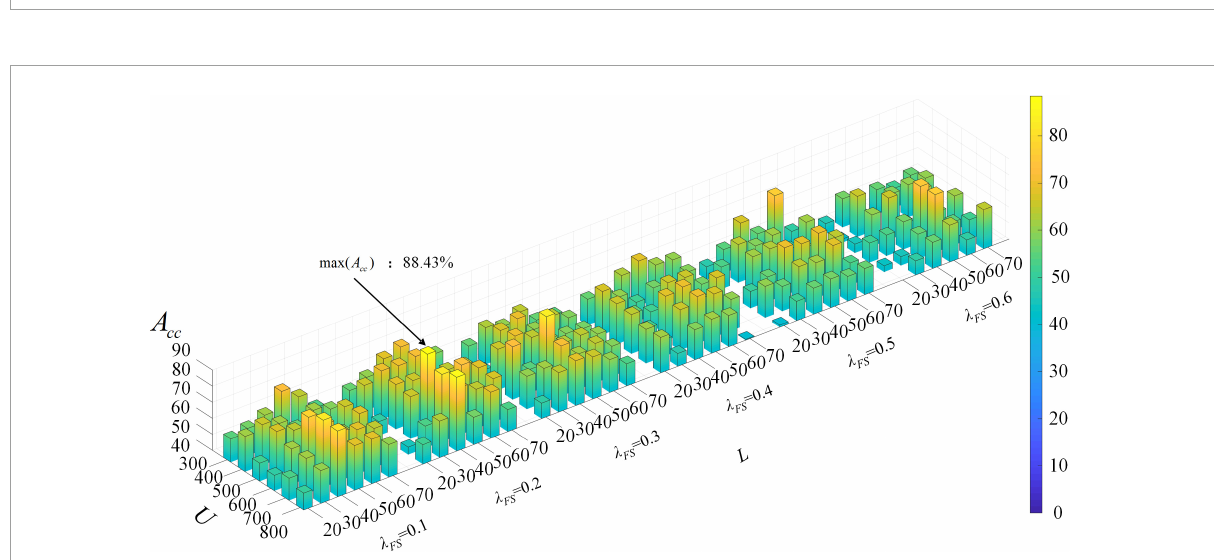
FIGURE7 Statistical classification accuracy is estimated by our proposed method with different values of hyperparameters. For clear visualization, HFCN thresholding parameter λ HD is set to 0.5. These results are obtained by LOOCV on whole